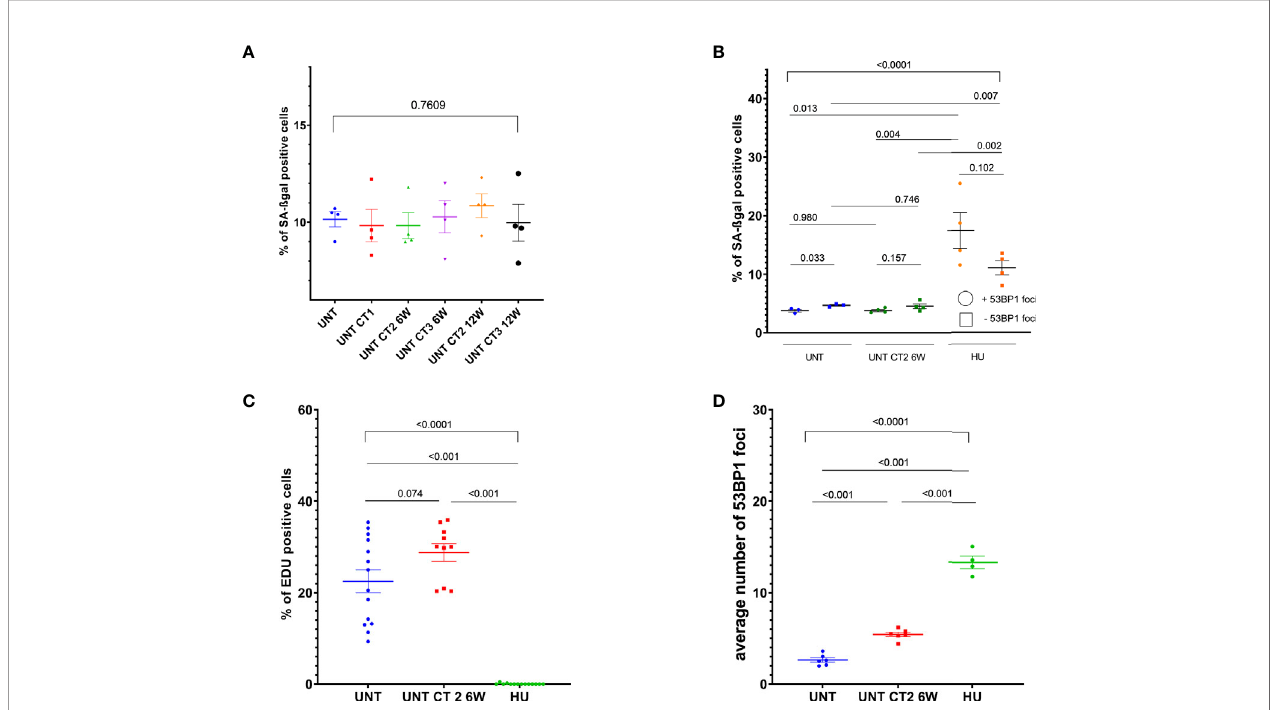
FIGURE 4 | Cell proliferation and senescence-associated beta-galactosidase (SA- b gal) activity analysis in MCF10A cells. Evaluation of SA- b gal staining (A, B) and EdU incorporation (C, D) in cells, which went through diagnostic CT scans and were further cultured for 6 weeks, using either inverse microscopy (Nikon Eclipse TS100) — (A) , or conventional fl uorescence microscopy (Leica DMI6000B) — (B – D) . Data are presented as bar plots +/ − SEM. (A) Percentage of SA- b gal positive cells in untreated (12 weeks “ aged ” ) and pre-treated at different CT rounds MCF10A cells in 6 and 12 weeks intervals. (B) Percentage of SA- b gal positive cells with or without 53BP1 foci. (C) Percentage of EdU positive cells. (D) Average 53BP1 foci number per cell, assessed after EdU labeling. Data from two independent experiments includes one technical duplicate. Each dot in (C) represents counting area (UNT, untreated age-matched to UNT_CT2_6 weeks control; CT1, cells after the 1st round of computed tomography; CT2, cells after the second subsequent diagnostic CT, HU, 0.5 mM hydroxyurea treatment for 96 h prior to fi xation in MCF10A cells as a control for senescence-like state and replicative stress; SEM, standard error of the